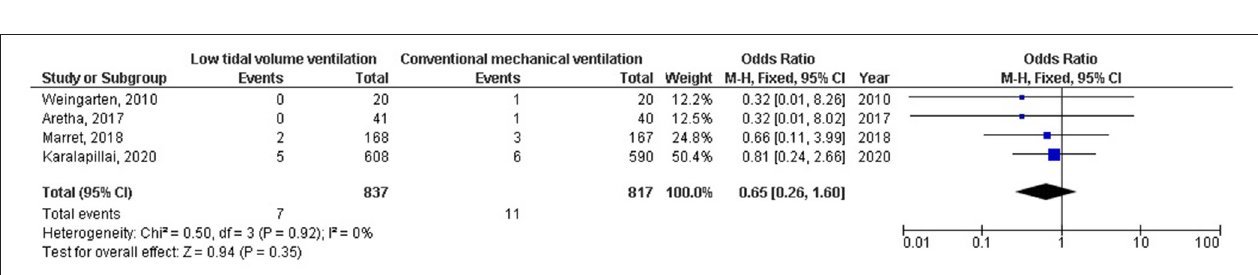
( p = 0.06) suggesting that any added study may affect this insignificant